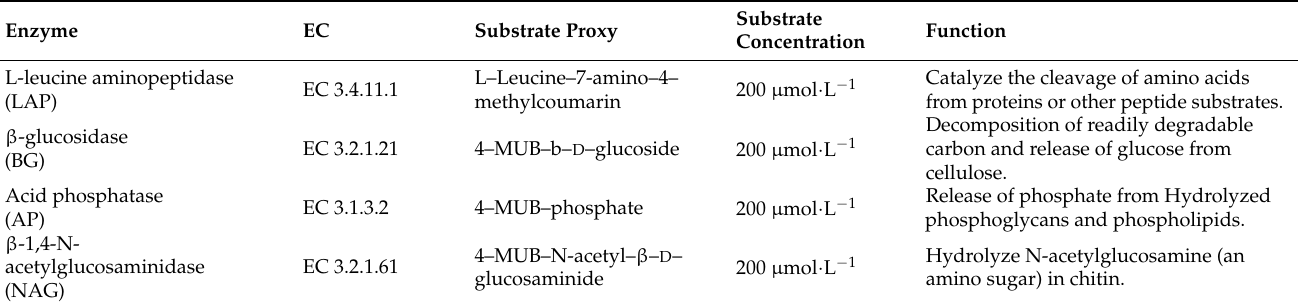
Table 2. Types, substrates and functions of soil extracellular